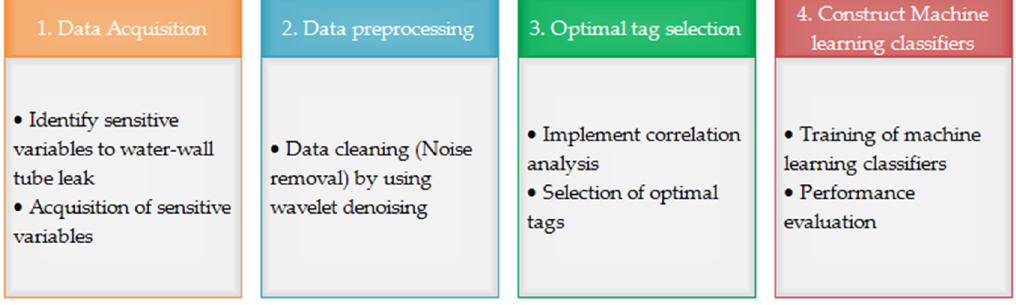
Figure 3. Overview of the proposed machine learning-based optimal sensor selection model .